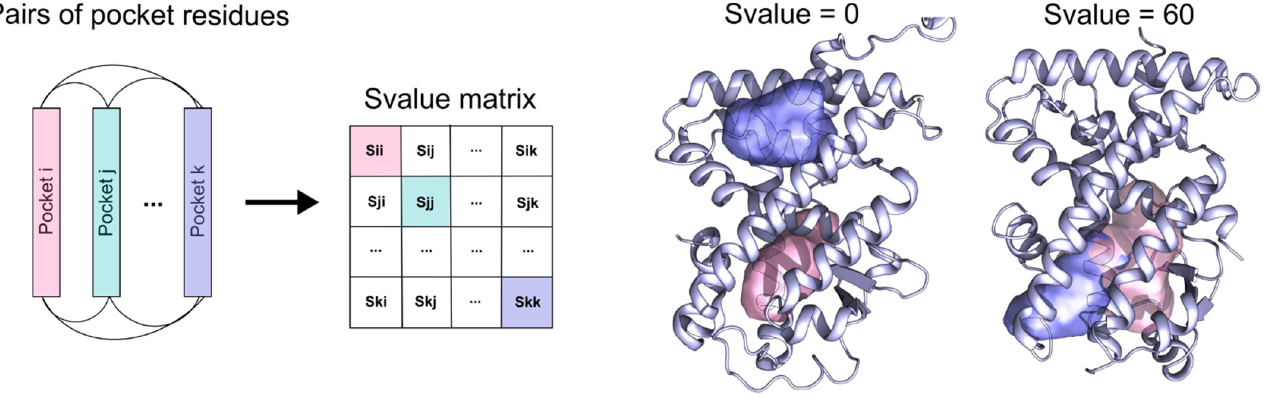
Figure 9. Description of the method. Pairs of pocket residues from the different PDB structures of the same receptor are compared based on the residue index (sequence numbering). The resulting similarity matrix contains all the similarity values ( S values ) of each pair of pockets. An S value of 0 indicates pockets that are located far within the protein and have no residue in common, while an S value of 60 indicates overlapped pockets that share residues.